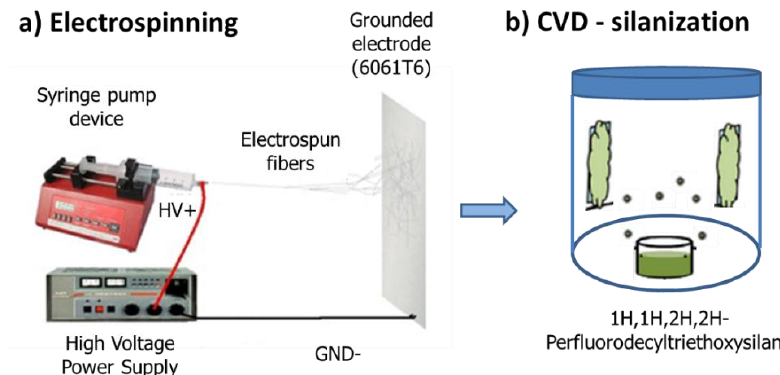
Figure 1. The scheme of the two different techniques employed in the preparation of the coating from the electrospinning process ( a ) to CVD-silanization ( b ).